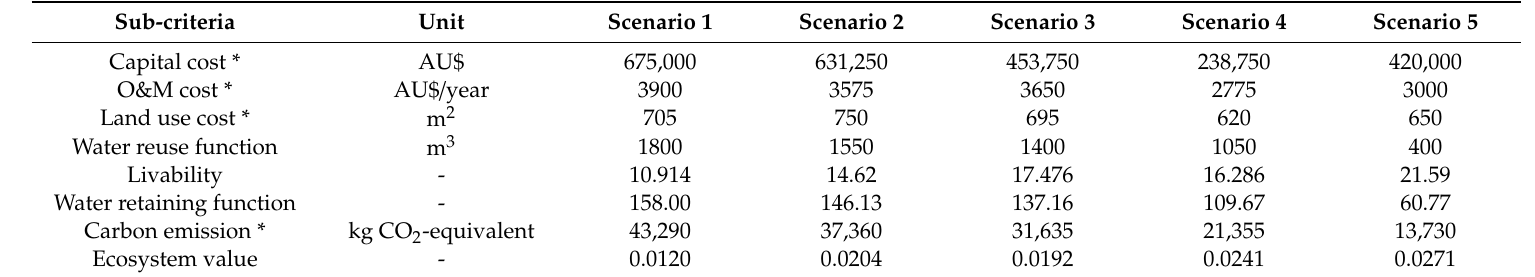
Table 12. The results of sub-criteria in economic, social, and environmental